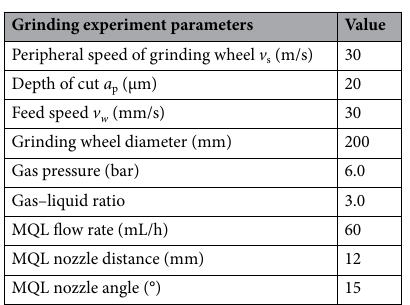
Table 2. Single grain and grinding wheel grinding experiment parameters.